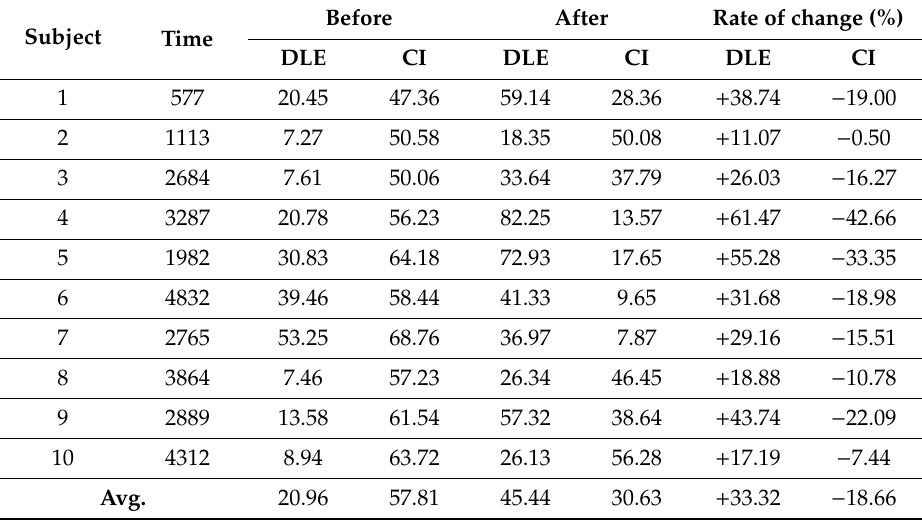
Table 3. Comparison of rate of change between DLE Index and CI Index.